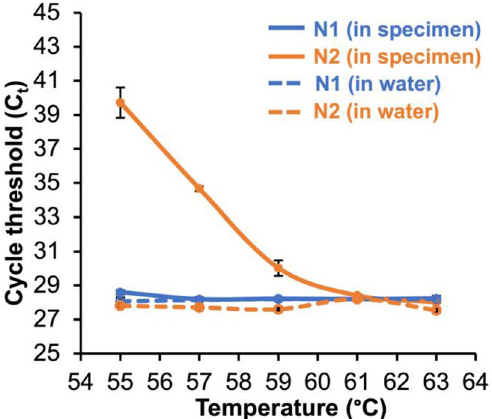
Figure 2. Annealing temperature has a small effect on the C t s of N1 and N2 using a pooled SARS-CoV-2 positive specimen spiked into water (blue and orange dotted lines, respectively) or for N1 when spiked into a pooled negative specimen (blue solid line), but annealing temperature has a large effect on the C t s of N2 when a pooled positive specimen is spiked into a pooled negative specimen (orange solid lines). Mean ± s.d. (N =